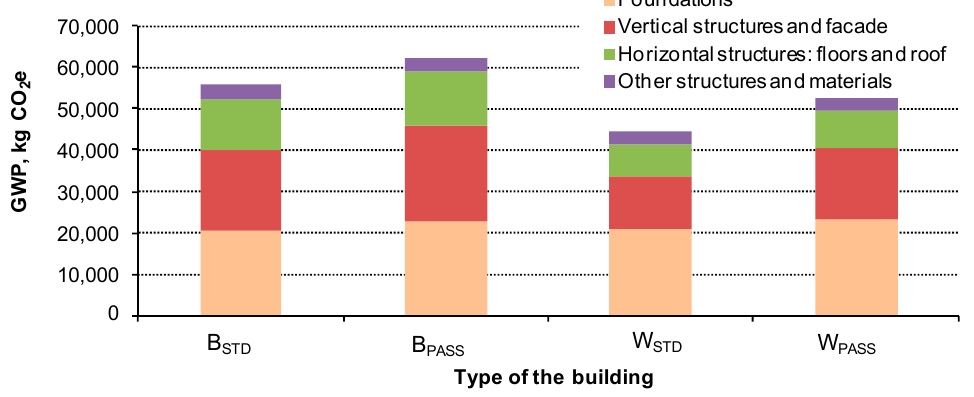
Figure 4. GHG emissions associated with the building construction.